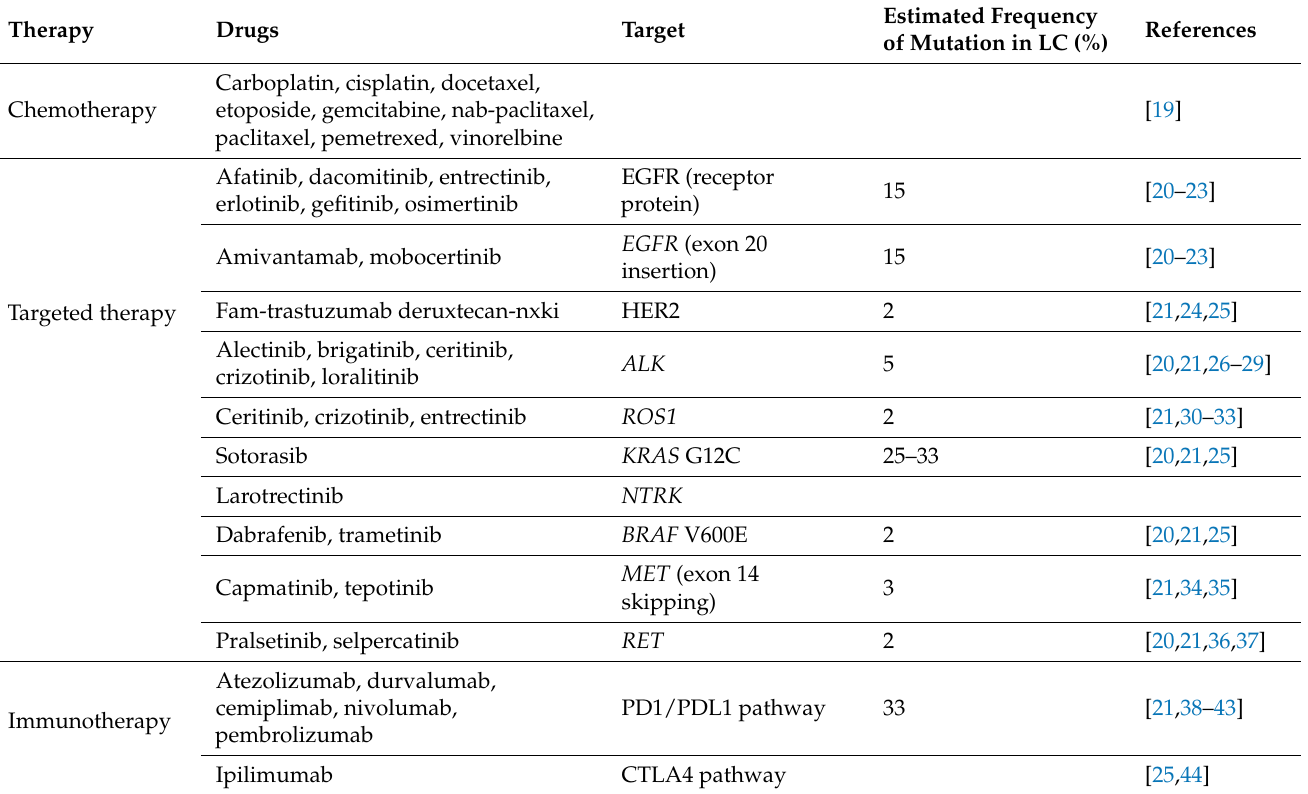
Table 2. FDA-approved drugs used in chemotherapy, targetable therapies, and immunotherapy against major oncogenes in LC (Gene names are